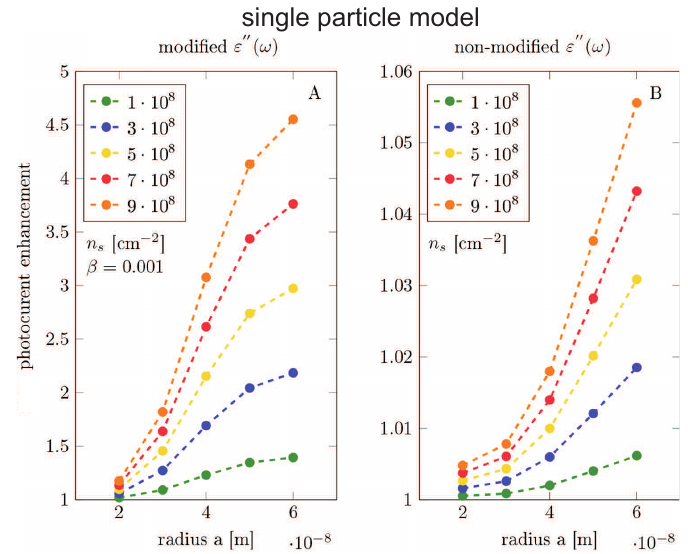
Figure 10. The single particle model—( A , B ): The photocurrent enhancement (Equation (28)) as a function of MNP radius calculated for the model of the single MNP on Si substrate. The photocurrent enhancement is showed for various MNPs concentrations n s . We used solar spectra AM1.5G. ( A ): ′′ ( ω ) by the plasmon damping. ( B ): Results obtained Results obtained in the model using the modified ε in the model using non-modified inappropriate dielectric function taken from the measurement in bulk